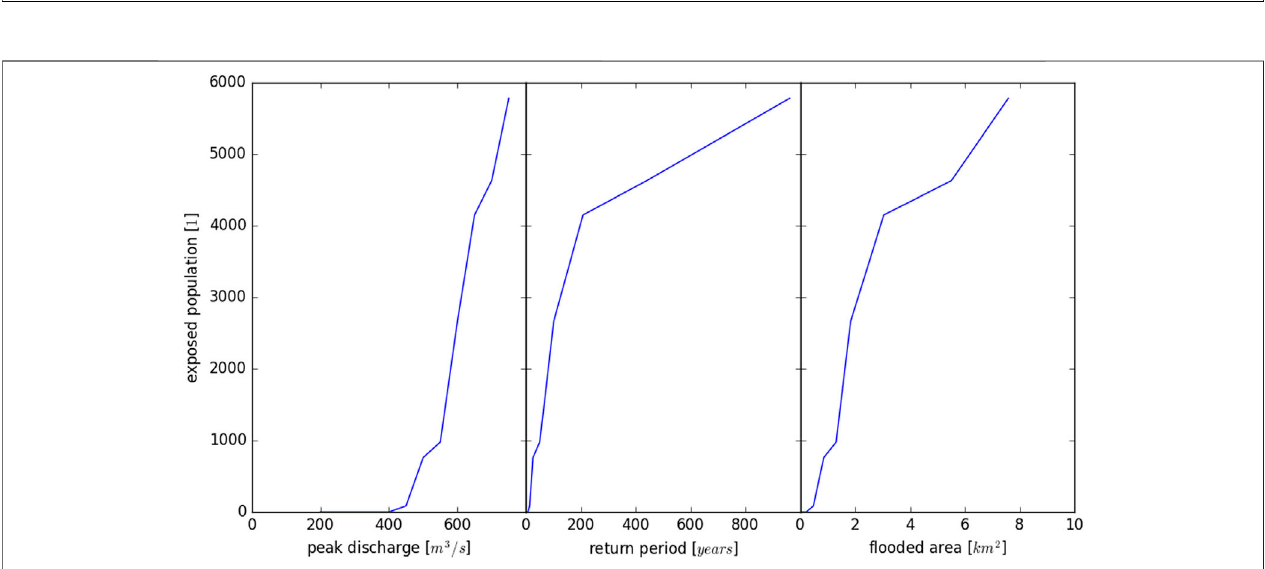
FIGURE 4 | Exposure footprint of the Emme River fl oodplain downstream of Burgdorf, Canton of Bern, Switzerland. Left: Relationship between fl ood magnitude expressed as peak discharge (m 3 /s) and exposed population. Center: Relationship between fl ood magnitude expressed as return period (years) and exposed population. Right: Relationship between fl ood magnitude expressed as fl ood extent (km 2 ) and exposed population.